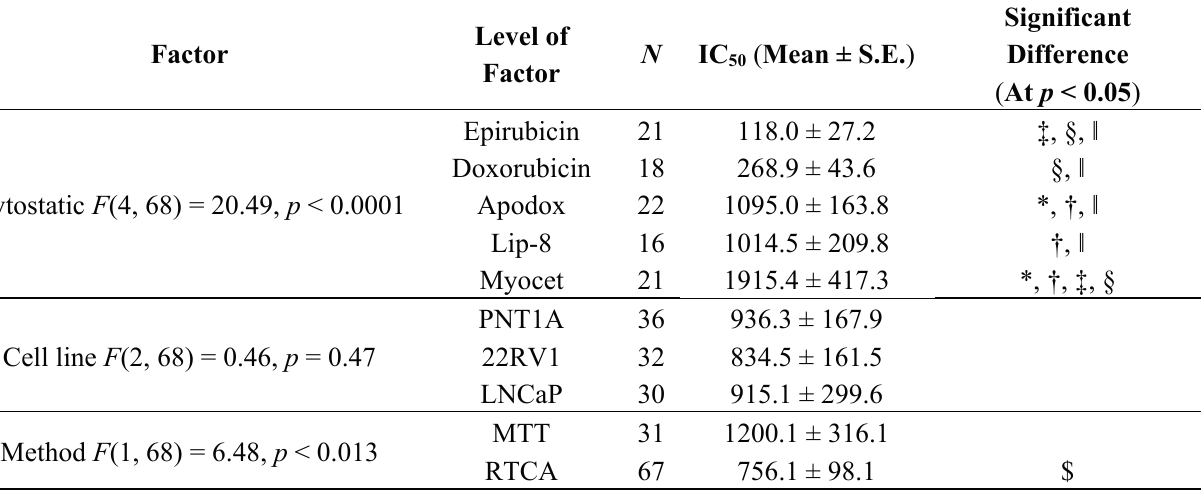
Table 1. Comparison of half-maximal inhibition concentrations (IC 50 ) for particular cell lines, cytostatics and used assay. S.E., standard error. Differences were considered significant, when p < 0.05. * Significantly different from doxorubicin (Analysis of variance (ANOVA) followed by Bonferroni post hoc testing) † Significantly different from epirubicin (ANOVA followed by Bonferroni post hoc testing) ‡ Significantly different from lip-8-dox (ANOVA followed by Bonferroni post hoc testing) § Significantly different from apodox (ANOVA followed by Bonferroni post hoc testing) ǁ Significantly different from myocet (ANOVA followed by Bonferroni post hoc testing) $ Significantly different from MTT (ANOVA followed by Bonferroni post hoc testing). Significant Level of N IC Factor ( Mean ± S.E. ) Difference 50 Factor ( At p < 0.05 ) Epirubicin 118.0 ± Cytostatic F (4, 68) = 20.49, p < 0.0001